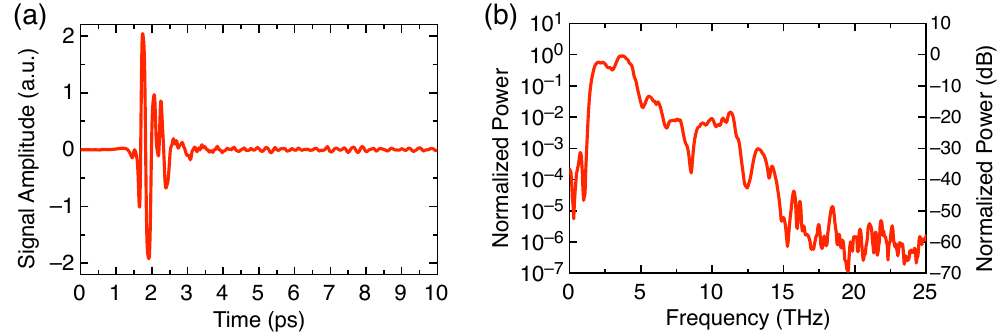
Figure 13. ( a ) THz time-domain signal and ( b ) the corresponding power spectrum achieved in dry-air environment using a compact terahertz setup based on a DSTMS crystal as THz generator and another DSTMS crystal as THz detector (each crystal was about 0.6 mm thick) and a pump laser with pulse length of 40 fs, 190 mW average power, 100 MHz repetition rate and 1560 nm central wavelength